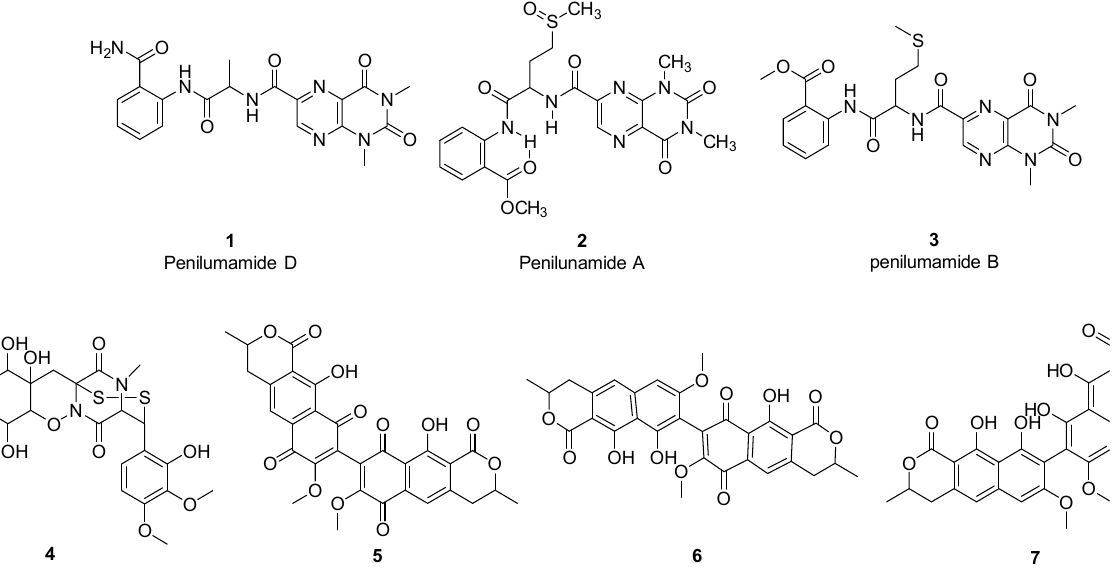
Figure 4. Structure of penilumamide D ( 1 ), penilumamide A ( 2 ), penilumamide B ( 3 ), pretrichoder- mamide C ( 4 ), xanthomegnin ( 5 ), viomellein ( 6 ), and vioxanthin ( 7 ).